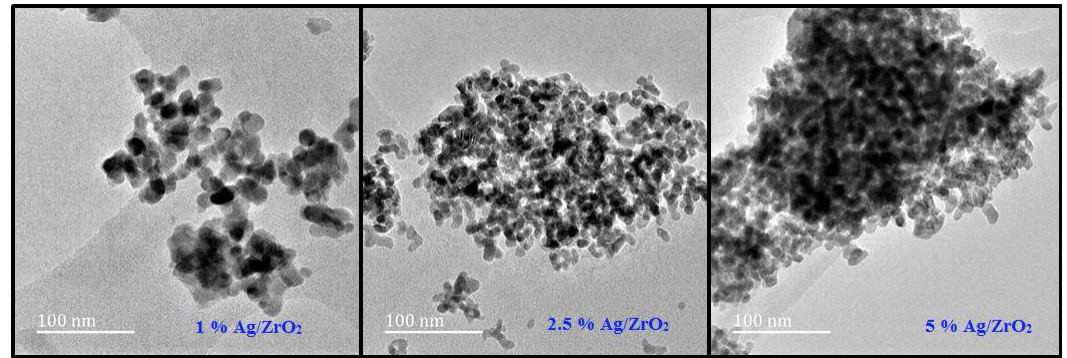
Figure 2. TEM micrographs of 1%, 2.5%, and 5% Ag 2 O – ZrO 2 catalyst.